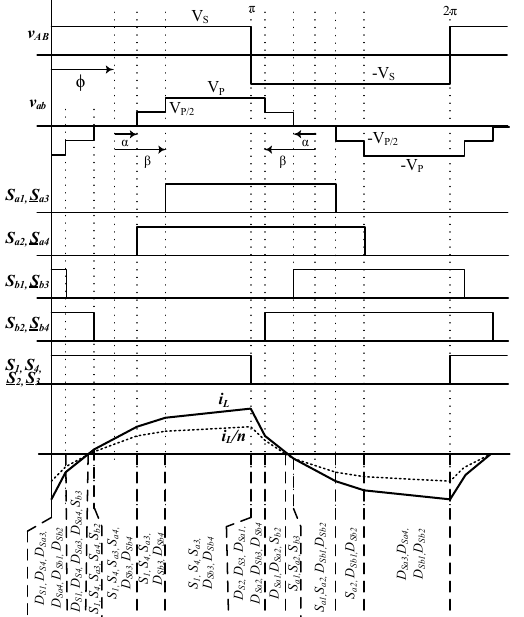
Figure 3. Switching states and corresponding 3L voltage ( (cid:1874) 3L-NPC bridge.